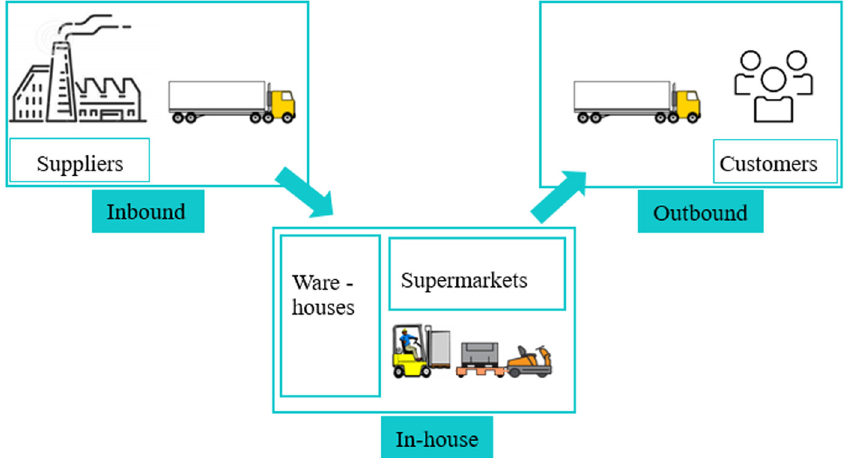
Figure 1: Inbound in - house outbound. Own